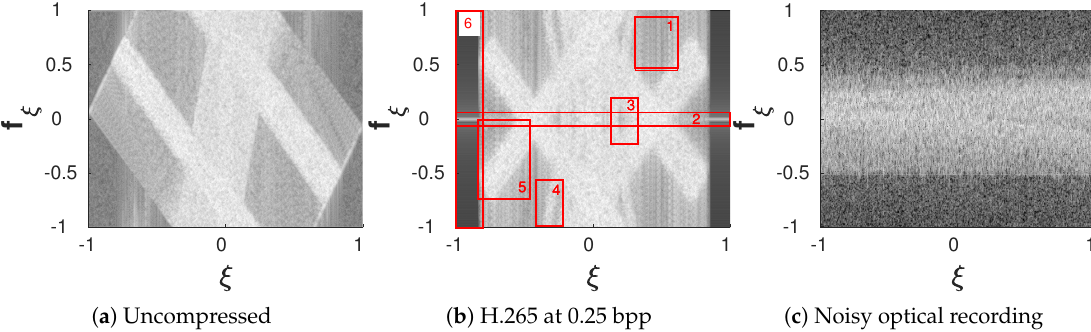
Figure 11. ( a , b ) Phase space footprint of 1D cross-section of un-/compressed (with H.265/High Efficiency Video Coding (HEVC)) multi-object hologram “DeepChess” from Interfere-IV [46]. ( c ) Noise in the optical holographic recording “Squirrel” from Interfere-IV [46] of an object with metallic